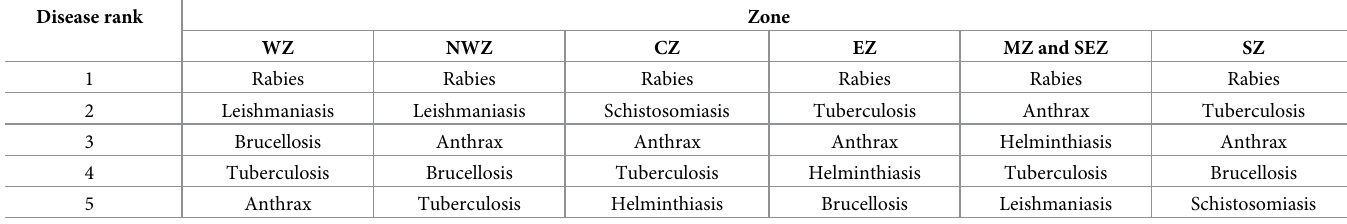
Table 7. List of top five NTZDs by zone through the FGD. Disease